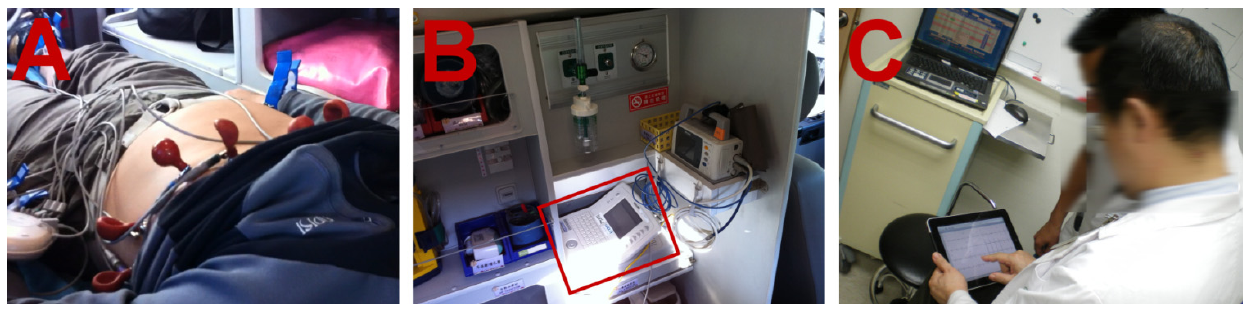
Figure 3. The demonstration of pre-hospital 12-Lead ECG